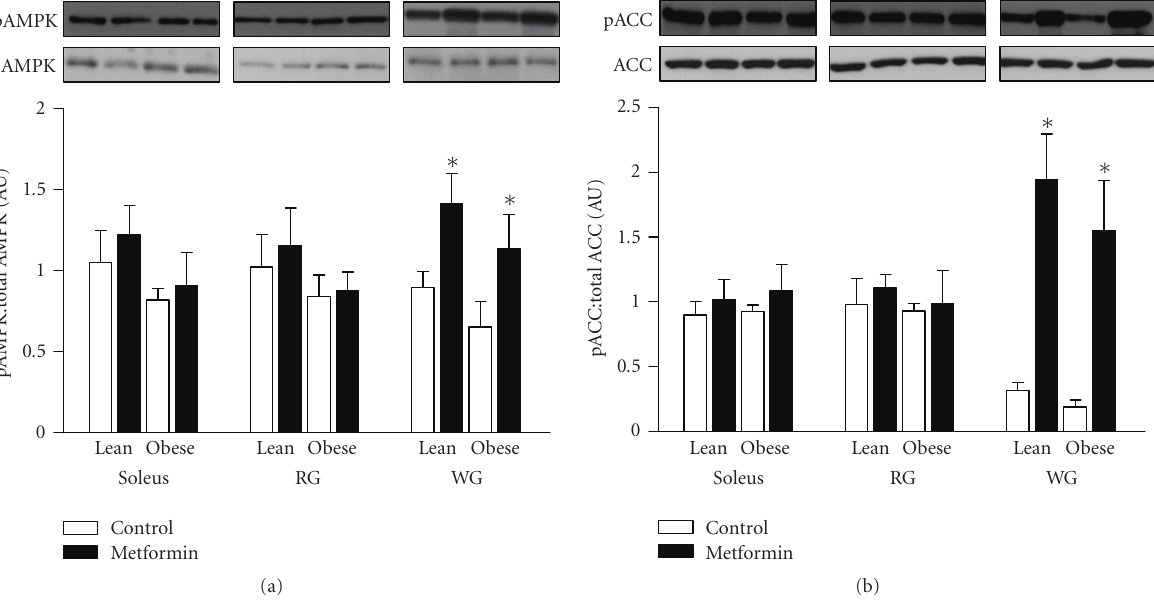
Figure 1: The e ff ect of daily vehicle (open bars) or metformin (filled bars) gavage on AMPK (a) and ACC (b) phosphorylation in soleus, RG, and WG. ∗ P < . 05 . AU: arbitrary